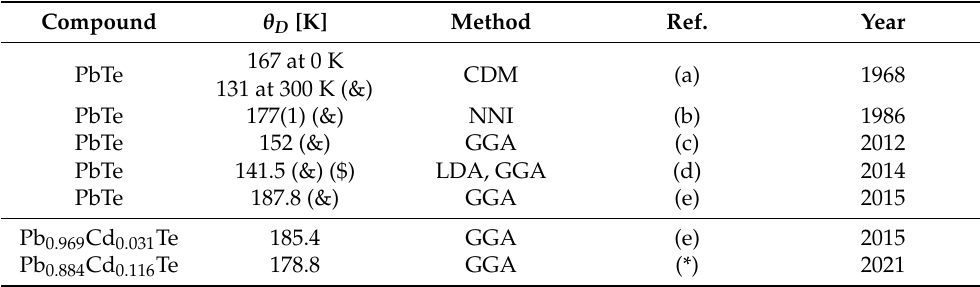
Table 13. Reported theoretical values of Debye temperature, θ D , for PbTe and Pb 1 − x Cd x Te ( x =